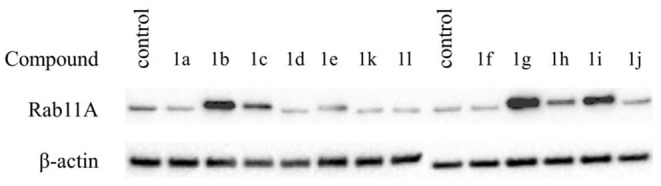
Effect of the studied compounds (1a–l) on Rab11A prenylation in HeLa cells. Cells were treated with phosphonocarboxylates at 100 μM for 48 h, lysed, and fractionated into cytosolic and membrane-rich fractions. Cytosolic fractions containing unprenylated proteins were separated by electrophoresis and western blotted for Rab11A and β-actin.